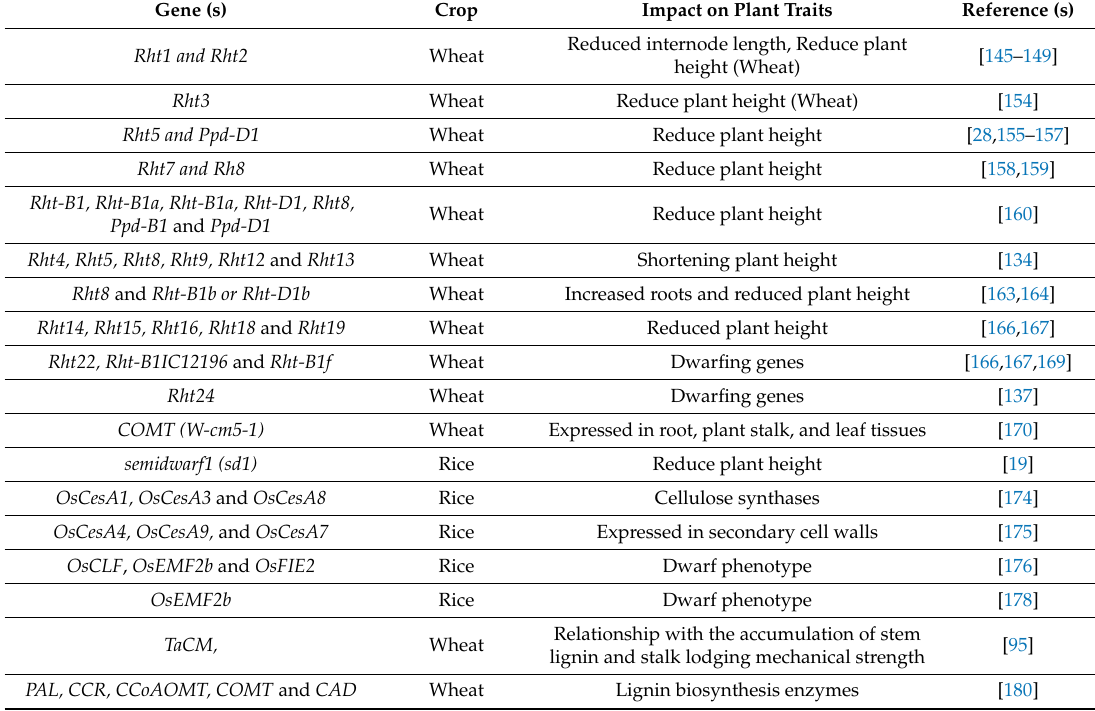
Table 3. Resistance genes associated with lodging resistance in wheat and